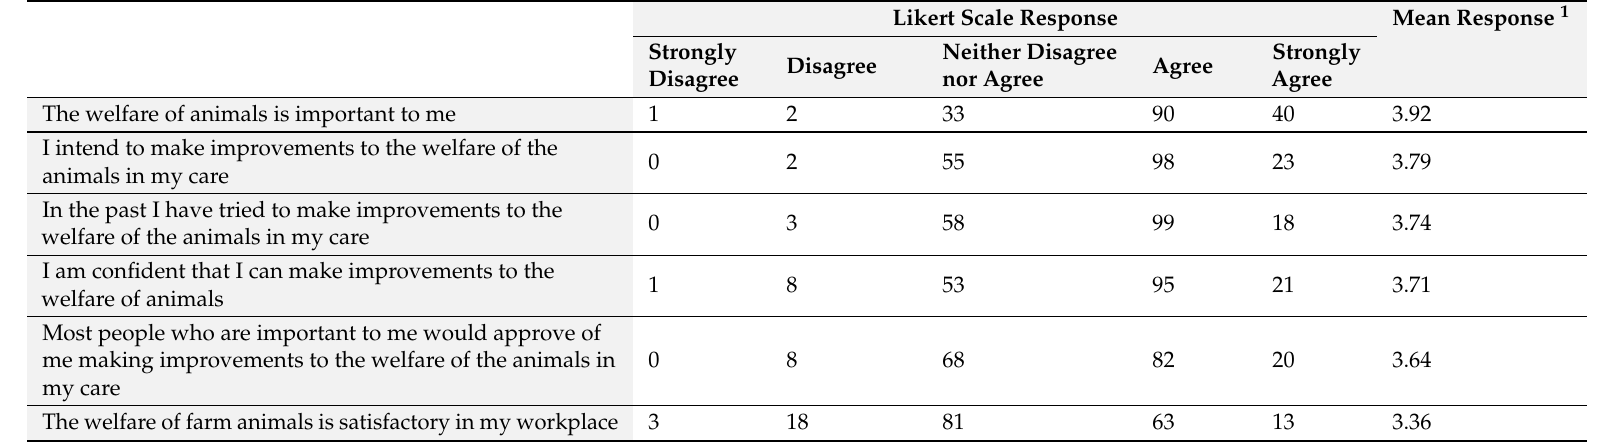
Table 2. Responses to general attitude questions about animal welfare, with di ff erences between mean